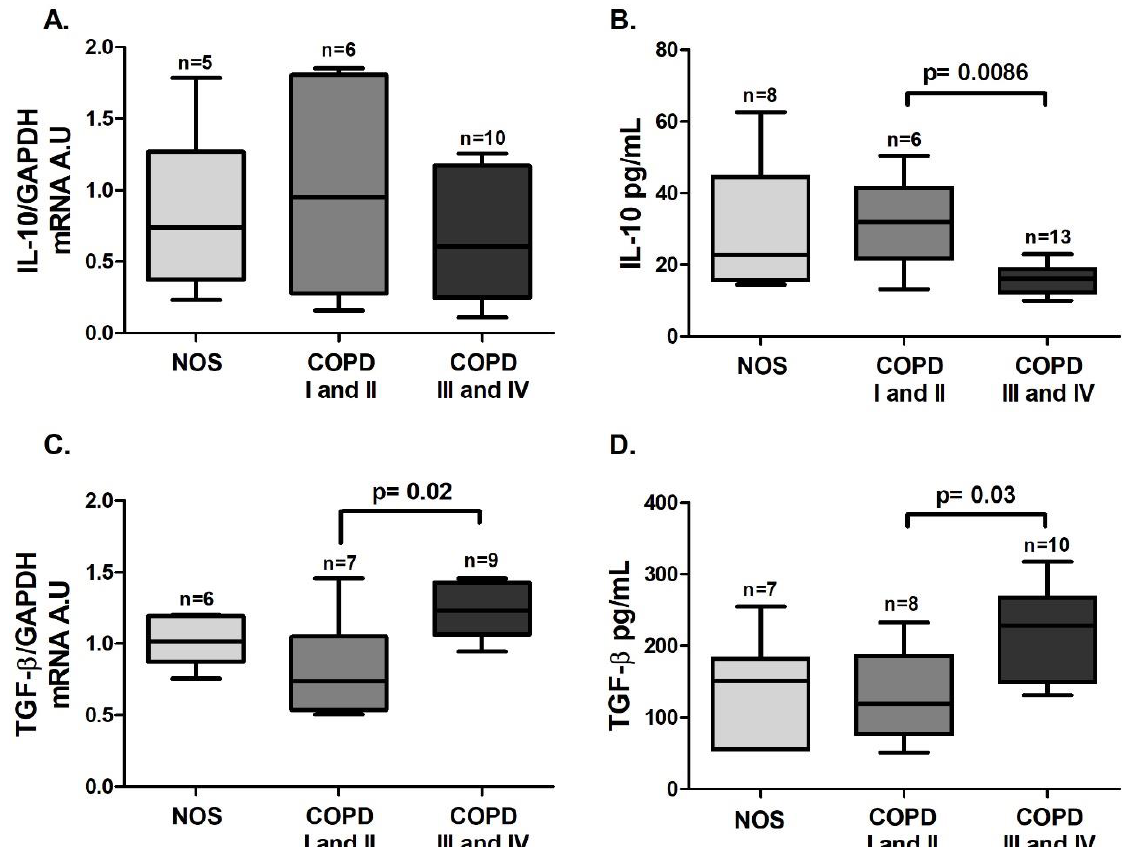
Figure 8. Treg-related cytokine in the systemic response. Treg-related cytokine expression in white blood cells ( A and C ) and plasma samples ( B and D ): ( A ) no differences were observed for IL-10 gene expression (Kruskal–Wallis test) among the groups; ( B ) decreased IL-10 level ( p = 0.0086, Kruskal–Wallis) in the COPD III and IV group compared to the COPD I and II group; ( C ) increased TGF- β gene expression ( p = 0.02, Kruskal–Wallis test) and ( D ) TGF- β levels ( p = 0.03, one-way ANOVA) in the COPD III and IV group compared to the COPD I and II group. The data are expressed as the median and interquartile range. A.U: Arbitrary